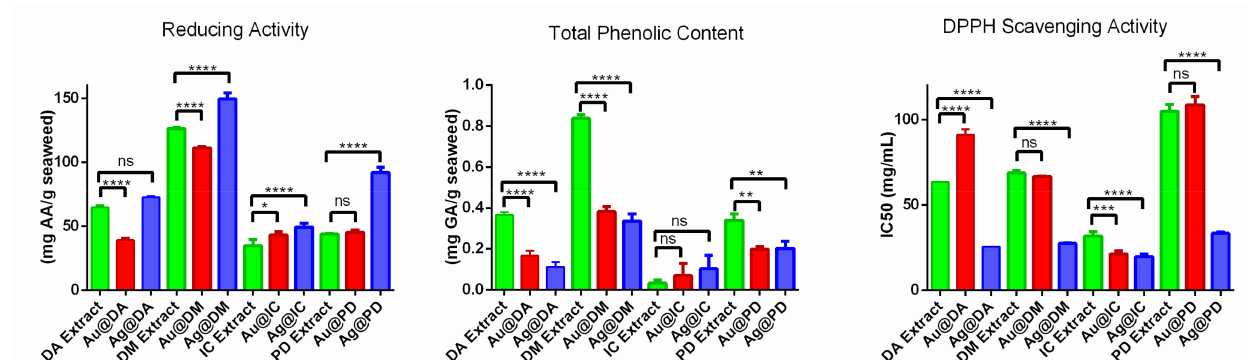
Figure 5. Graph bar showing the results of reducing power, total phenolic content, and 1,1-diphenyl-2-picryl-hydrazyl (DPPH) scavenging activity of DA, DM, IC and PD extracts before and after the synthesis of gold and silver nanoparticles. n.s. p > 0.05, * p ≤ 0.05, ** p ≤ 0.01, *** p ≤ 0.001, **** p ≤